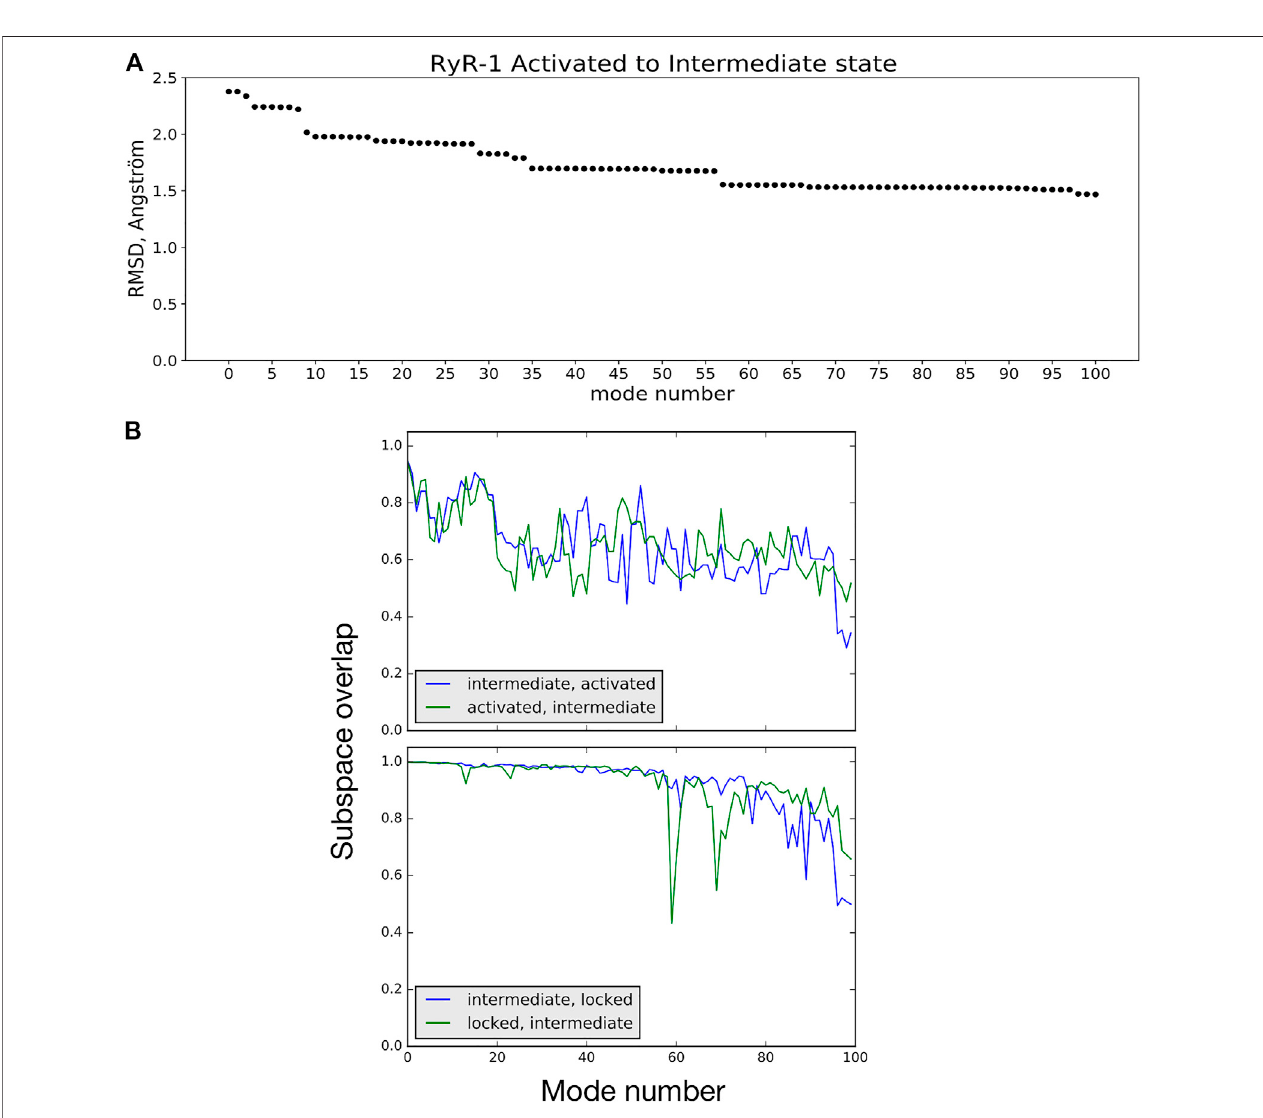
FIGURE 4 | (A) RMSD between the activated and intermediate conformational states is reduced by 38% by displacing atoms along a linear combination of NM vectors. Mode 0 refers to the initial RMSD between the two model structures. (B) Subspace-overlap analysis for the 100 lowest-frequency normal mode vectors of selectedpairsofconformationalstatesoftheRyR1receptor. Top: Inblue,overlapofeachintermediatestatemodeonthesubspaceofthe100activated-statemodes.In green, overlap of each activated state mode on the subspace of the 100 intermediate-state modes. Bottom: Same coloring as in Top , but for the intermediate and locked state